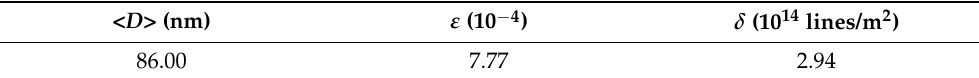
Table 3. NiO films average values of crystallite size, dislocation density, and